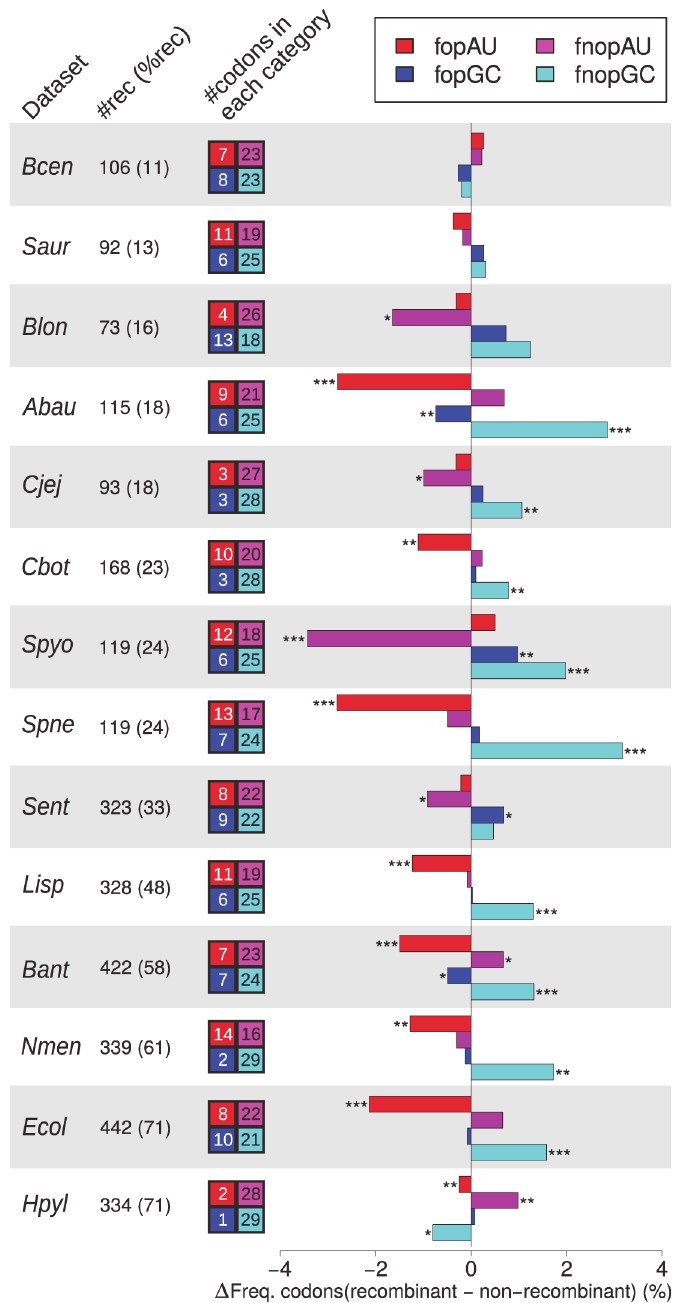
Figure 2. Effect of recombination on codon usage of core genes. Difference in frequency of optimal (fop) or non-optimal (fnop) codons (as determined by RP method) in recombining and non-recombining genes in each dataset for AU-ending (redish colors) and GC-ending (blueish colors) codons. The recombination status of genes was determined as in Fig. 1, only datasets with more than 10% recombining genes are shown. A positive difference indicates that recombining genes are enriched in a category of codons, while a negative difference indicate depletion. Stars indicate significance of a Student ’ s t -test between recombining and non recombining genes. Colored boxes on the right of dataset names indicate the numbers of AU-ending and GC- ending optimal or non-optimal codons used by the taxon (detailed in S2 Table). Symbols and dataset abbreviations as in Fig. 1; shading is only used to distinguish between datasets. It should be noticed that variations in fopGC and fnopAU (resp. fopAU and fnopGC) are not totally independent (typically, for all amino-acids encoded by two synonymous codons, if the optimal codon is GC ending, the non-optimal is AT- ending).